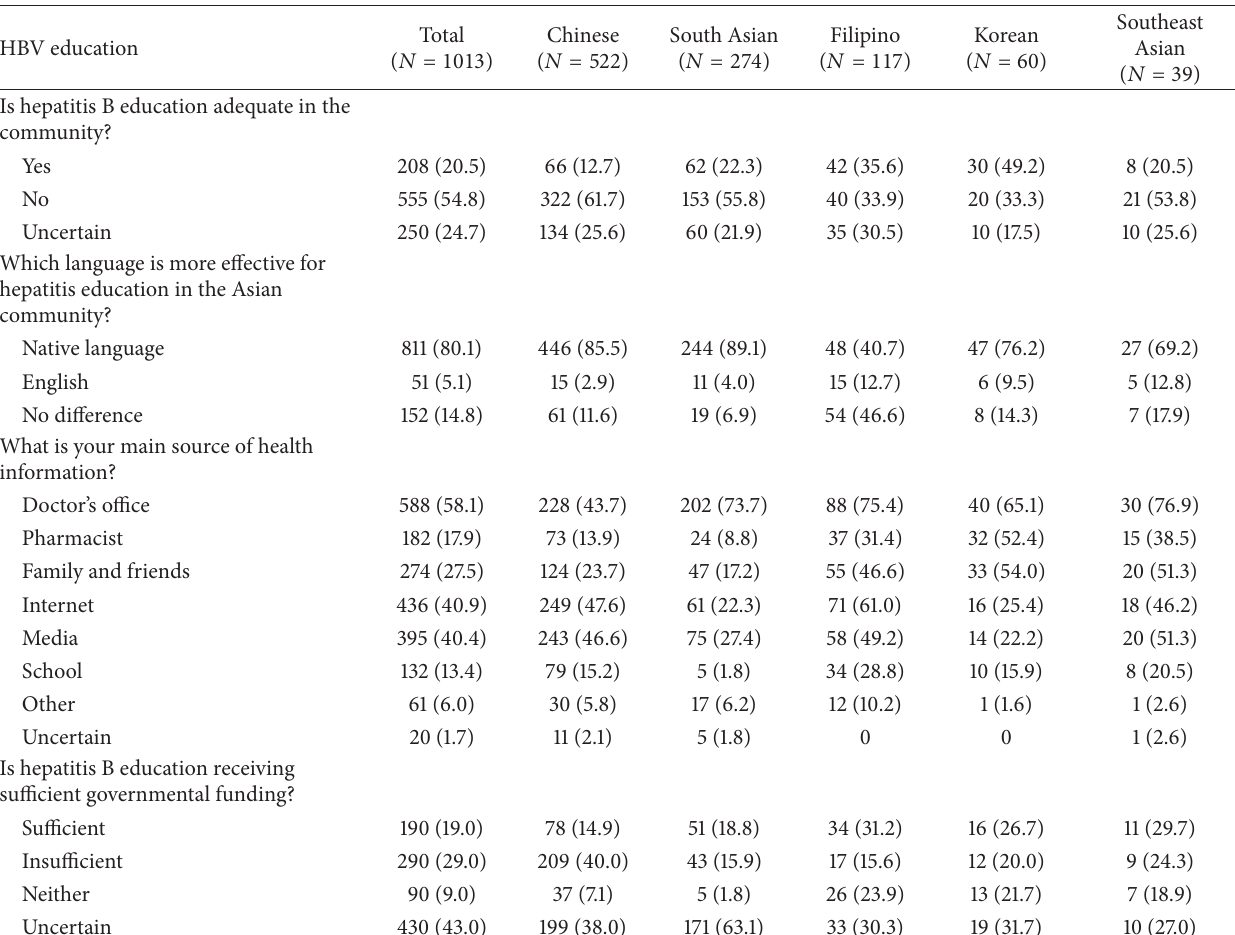
Table 6: Opinions on HBV education by survey